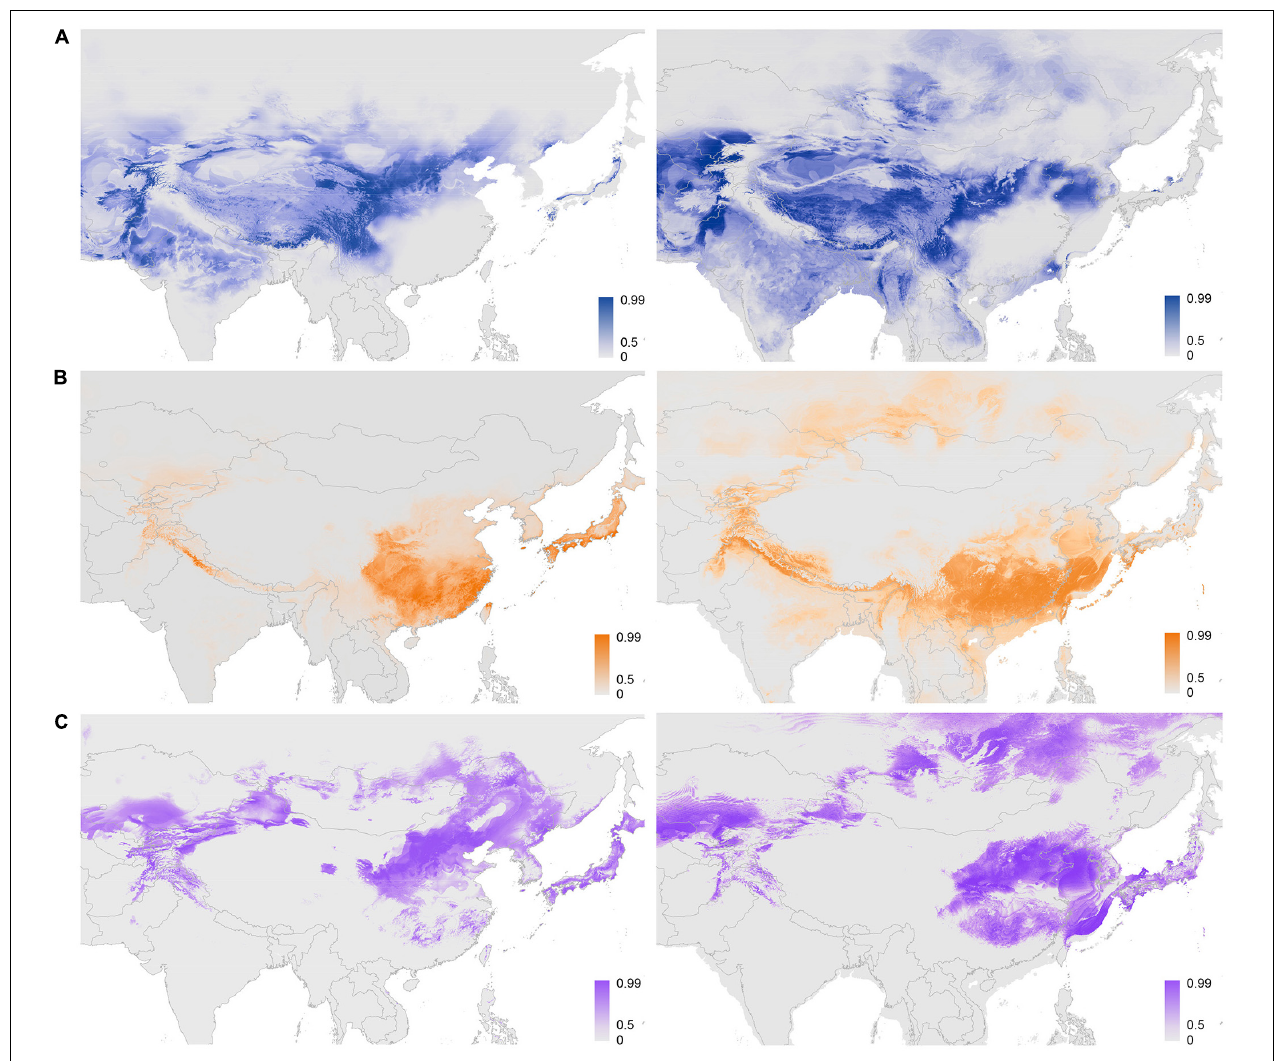
FIGURE 4 | Potential distribution area of Ajania and two subclades of Chrysanthemum predicted by the maximum-entropy model. (A–C) Represent the predicted distributions of Ajania , Ch. indicum -complex and Ch. zawadskii -complex, respectively, during the current period (left) and during the Last Glacial Maximum (LGM) (right). Shadings in color show the probability of geographic occurrences. The prediction for the Korea–Japan distributed Ajania species is shown in Supplementary Figure 5